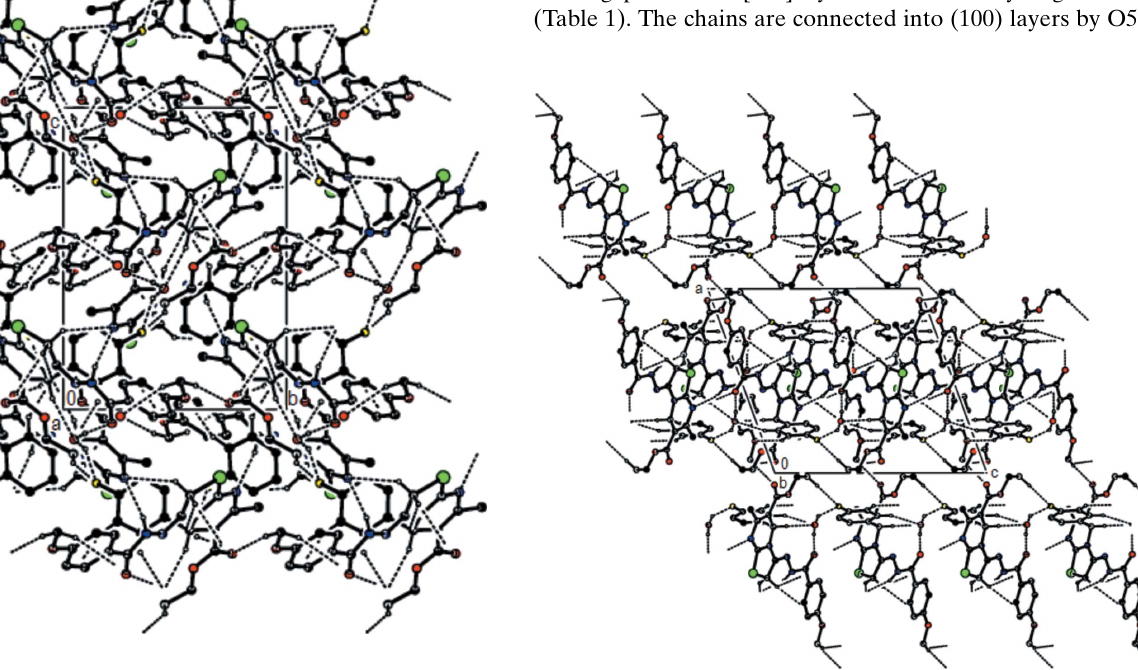
(Table 1). The chains are connected into (100) layers by O5—